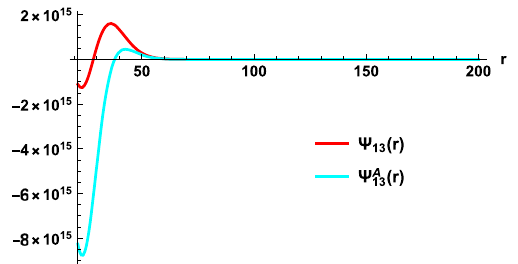
Fig. 2 (Left) Potential V dRN ( r ) as function of r ∈ [ r + = 1 . 99 , 200 ] with M = 1 , Q e = 0 . 01 , Q m = 0 . 05 ,ω = 2 . 95 , q = 20 , l = 13 ,μ = 3. A blue dot ( • ) denotes a local minimum at r = 17 . 9, implying a trapping well. Here, one has V (cid:15)